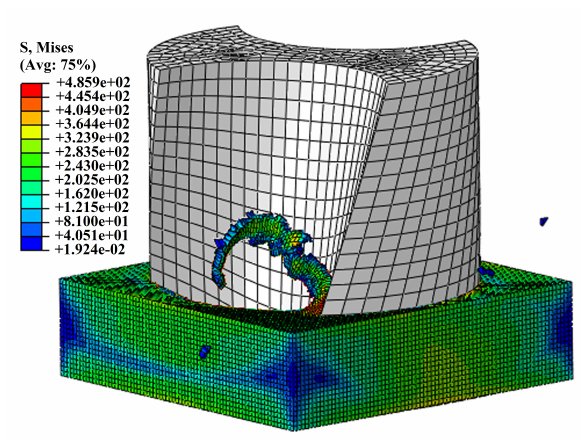
Fig. 2. Distribution of stress field